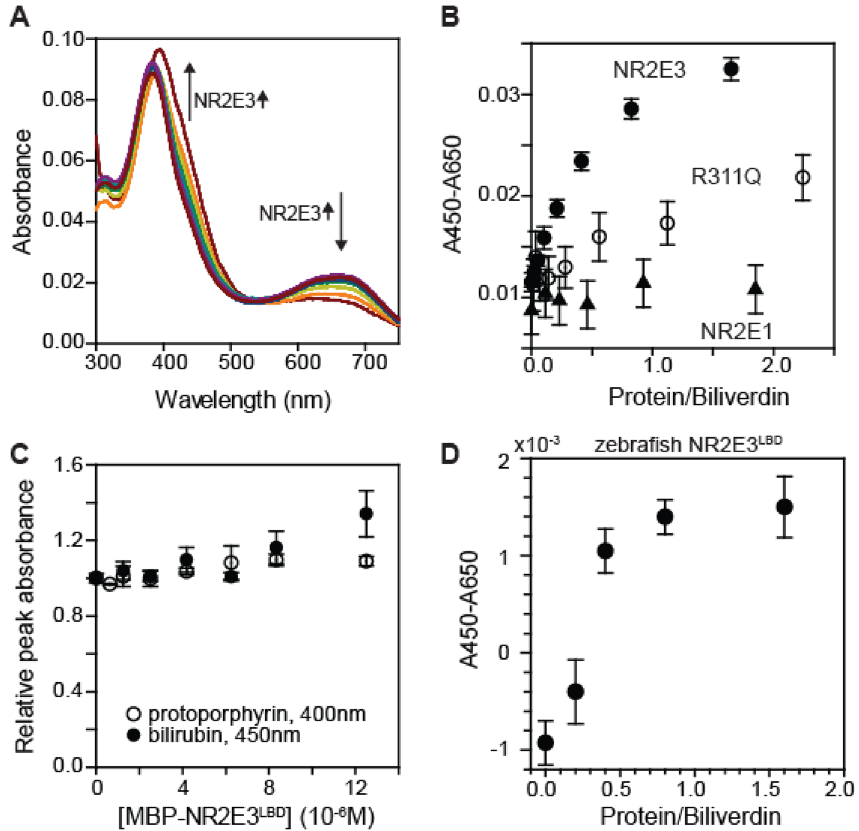
Figure 2. Biliverdin specifically binds to MBP-NR2E3 LBD in vitro. ( A ) Visible spectra of biliverdin (5 μM) in the absence and in the presence of varying amounts of MBP-NR2E3 LBD . The blue peak shifts from 390 to 450 nm, while the red peak intensity diminishes upon binding to MBP-NR2E3 LBD . ( B ) Biliverdin stoichiometrically bound to MBP-NR2E3 LBD (filled circle). MBP-NR2E3 LBD R311Q variant (open circle) showed a weaker binding to biliverdin (5 μM). MBP-NR2E1 LBD (triangle) did not show any evidence of binding to biliverdin. Averages and standard deviations (n = 3) are presented. ( C ) Effect of MBP-NR2E3 LBD on visible spectra of (filled circle) bilirubin and (open circle) protoporphyrin IX (average and standard deviations, n = 3). ( D ) Effect of MBP-zebrafish NR2E3 LBD to the visible spectrum of biliverdin (average and standard deviations, n = 3). The concentration of biliverdin was identical to the one used in Fig. 2A,